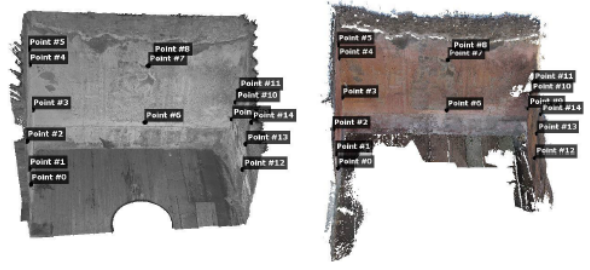
Figure 5. GCPs chosen on the laser scanner point cloud (on the left) and corresponding points on the photogrammetric point cloud (on the